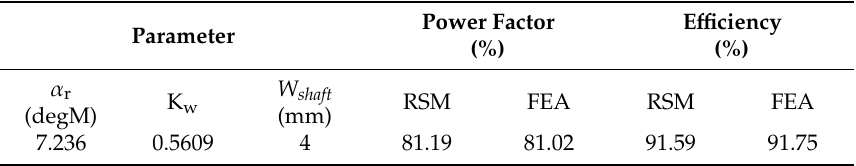
Table 6. Optimal design result.